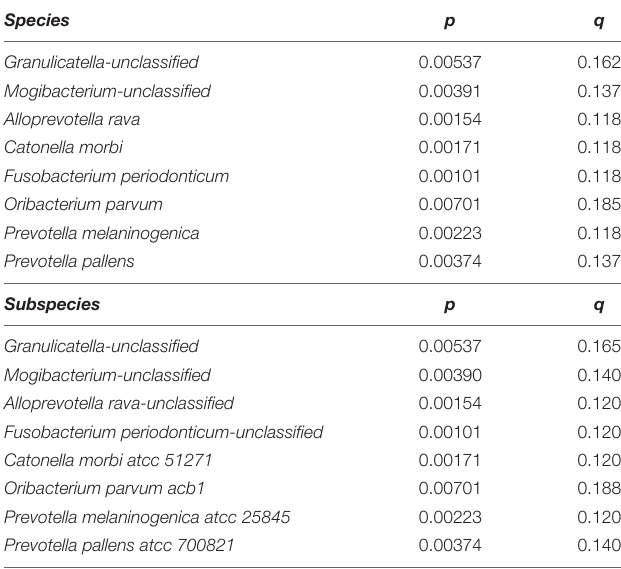
TABLE 1 | Eight species and eight subspecies had significantly higher values among healthy children than in T1D children. Species p q